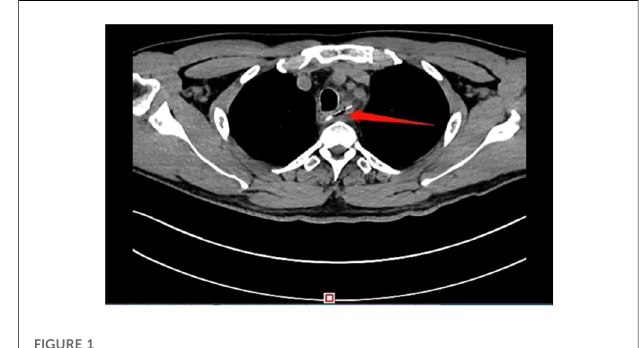
FIGURE 1 Chest CT showed a hyper-dense shadow of a fi sh bone shape in the upper Esophagus.